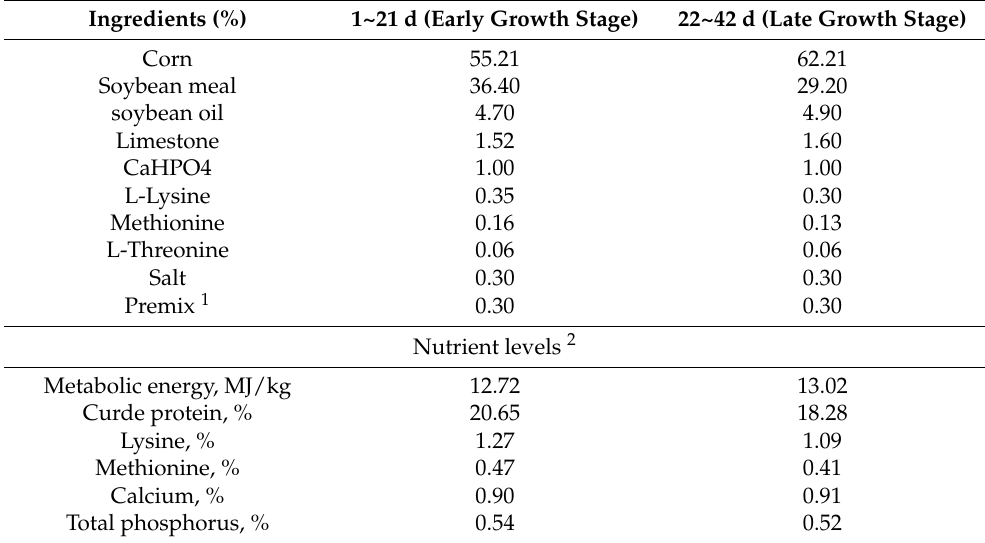
Table 1. Experimental basal diet composition and nutrient